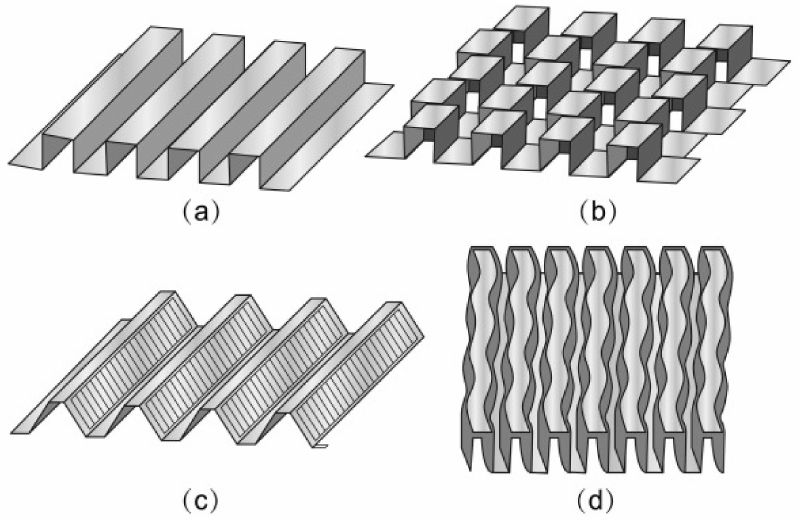
Figure 1. Heat exchanger classification ( a ) plain rectangular fins: ( b ) offset strip fins, ( c ) louvered fins ( d ) wavy